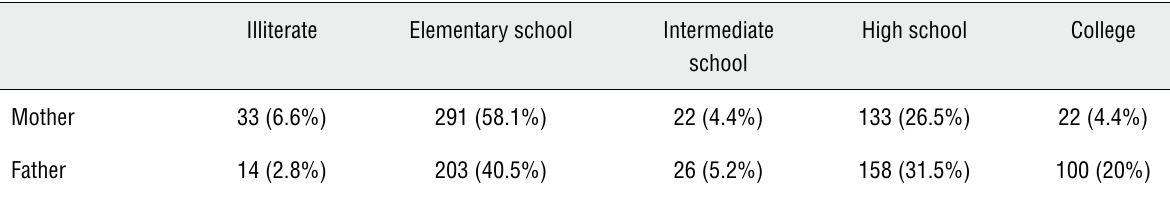
Table 3 - Educational status of parents